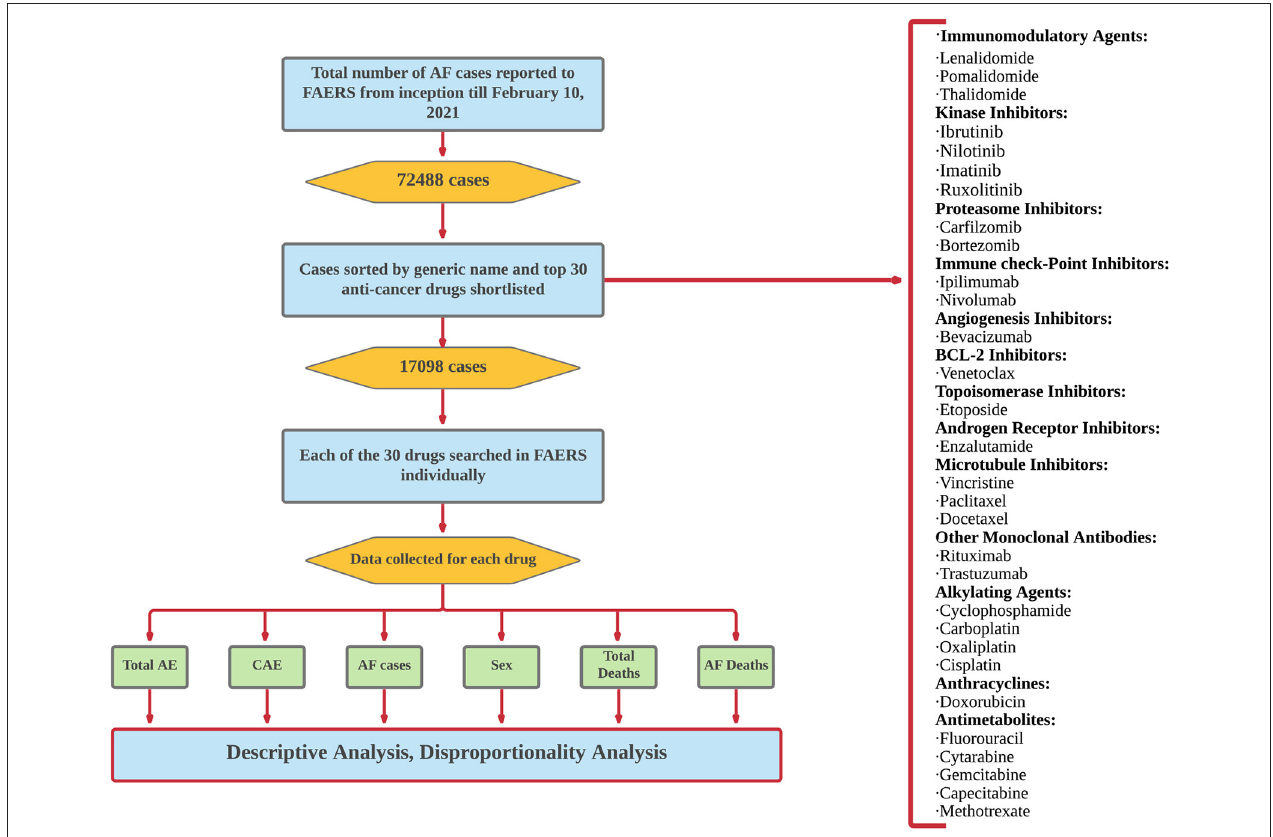
FIGURE 1 | Algorithm of FAERS search and selection of anti-cancer drugs reported for AF.